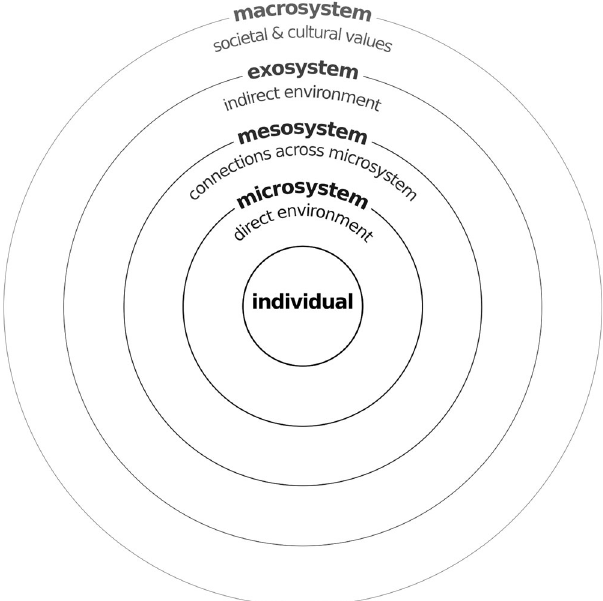
FIG. 2. A visual representation of Bronfenbrenner ’ s [33] organization of ecological systems theory as a set of concentric systems encompassing an individual — moving outward from the center are the — micro-, meso-, exo-, and